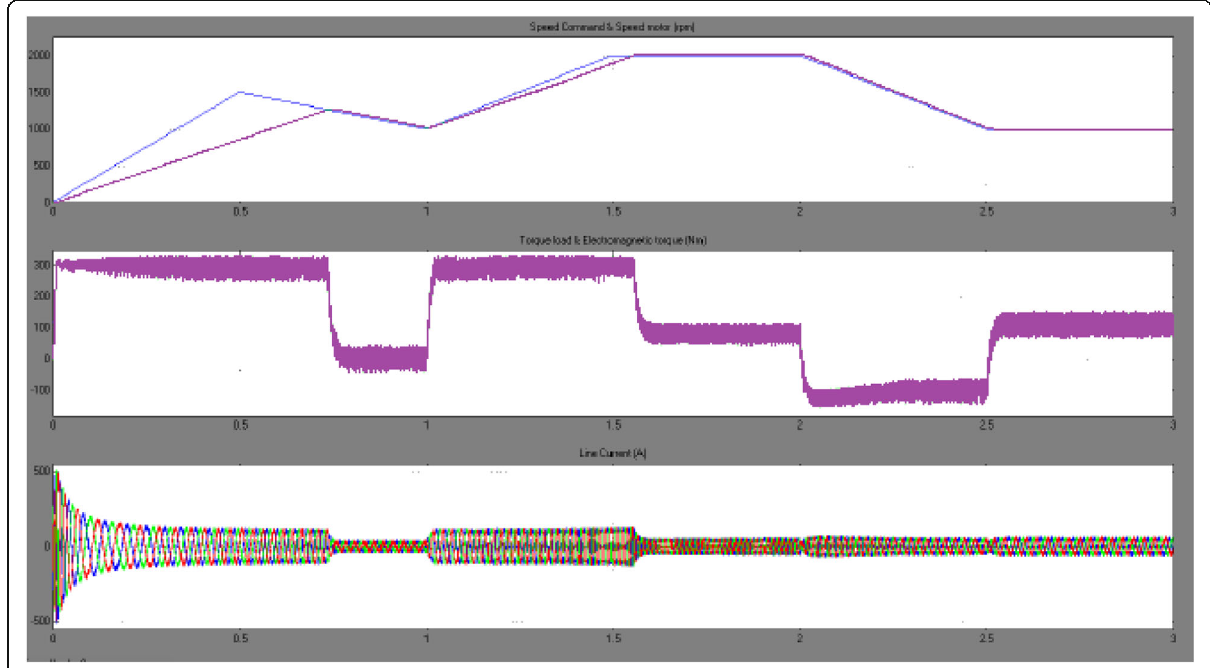
Fig. 8 Speed command, actual motor speed, currents, and